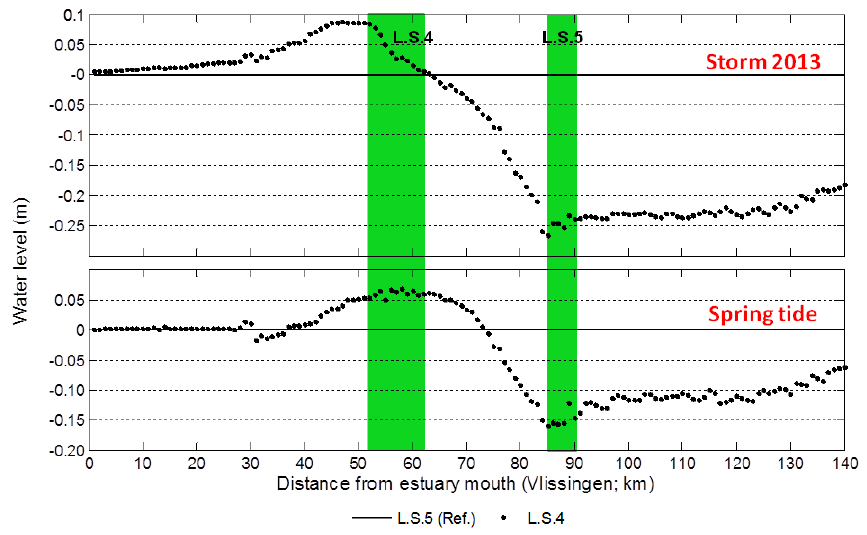
Figure 12. Scenarios with different wetland (with surface area = 1500ha) locations relative to 1500ha reference scenario ( = L.S.4). Scenar- ios given for spring and storm (2013) tide. The green areas in the figure show the locations of the different wetlands along the estuary in the model.